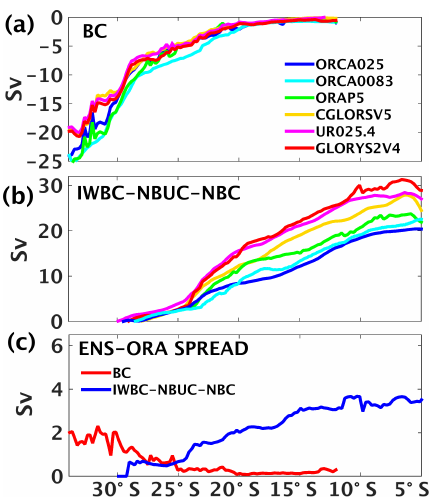
Figure 10. The transports (Sv) within 6 ◦ of the west coast for the (a) BC and (b) IWBC–NBUC–NBC system, following the isopycnal limits of the South Atlantic western boundary water masses as in Mémery et al. (2000) and Donners et al. (2005). The TW, SACW, and AAIW limits are defined in kgm − 3 with σ < 25 . 5, 25 . 5 ≤ σ < 27.1, and 27 . 1 ≤ σ < 27 . 3, respectively. The ENS-ORA spread (Sv) of the western boundary current transports is displayed in (c)